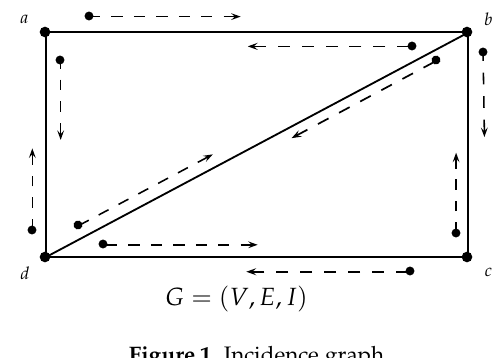
Figure 1. Incidence graph.